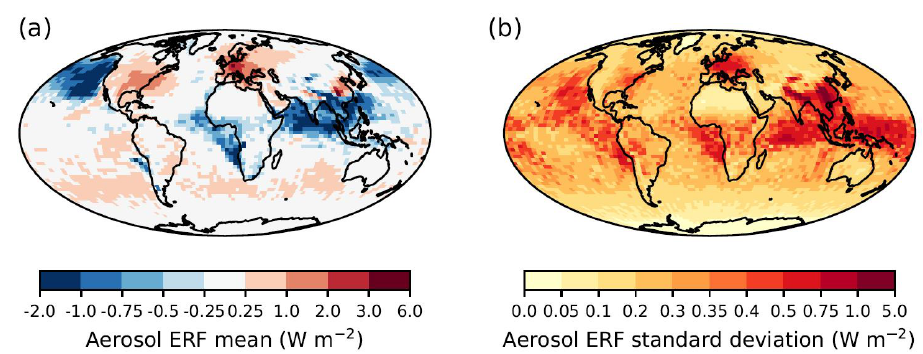
Figure 5. (a) Mean and (b) standard deviation of 1978–2008 aerosol ERF. Values were calculated using output from 270000 emulator- derived model variants at the individual pixel level. These samples of model variants are informed by the expert-elicited parameter